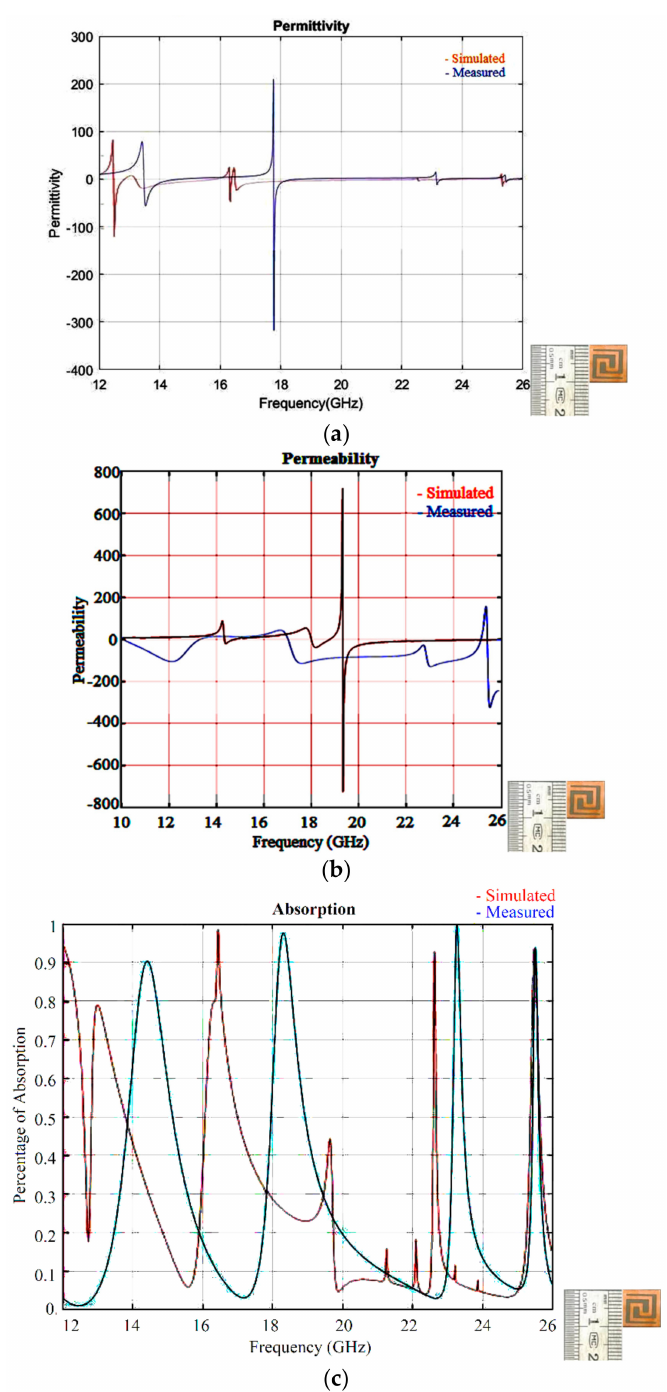
Figure 7. Simulated and measured results for Rogers RT 4003 and 6 × 6 ground ( a ) permittivity vs. frequency graph, ( b ) permeability vs. frequency graph, ( c ) percentage of absorption vs. frequency